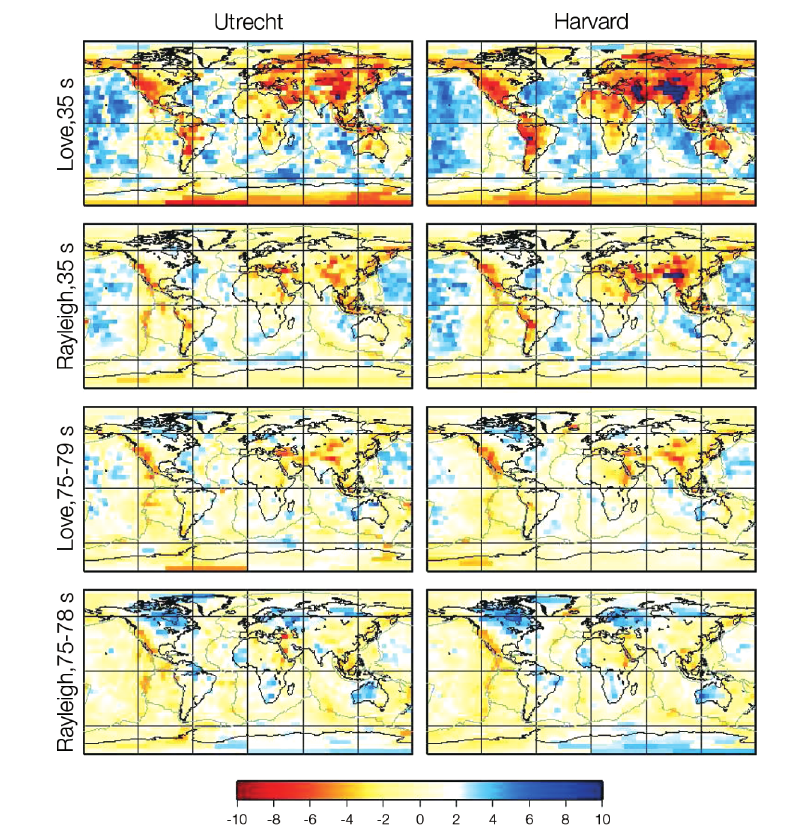
Fig. 1. Percent perturbations in phase velocity with respect to PREM, derived from Trampert and Woodhouse’s (2001) ( left ) and Ekström et al. ’s (1997) ( right ) databases. For each database, the results of inverting four inde- pendent subsets are shown: Love waves at 35 s ( top ), Rayleigh waves at 35 s ( middle , top ), Love waves at 75 s (Harvard) or 79 s (Utrecht) ( middle , bottom ), Rayleigh waves at 75 s (Harvard) or 78 s (Utrecht) ( bottom